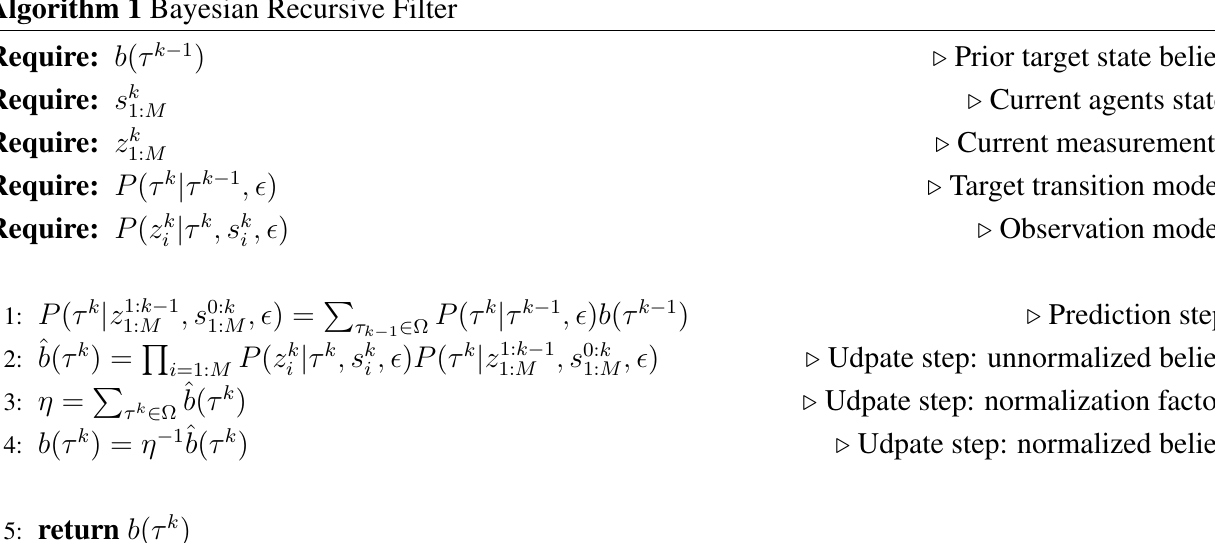
Algorithm 1 Bayesian Recursive